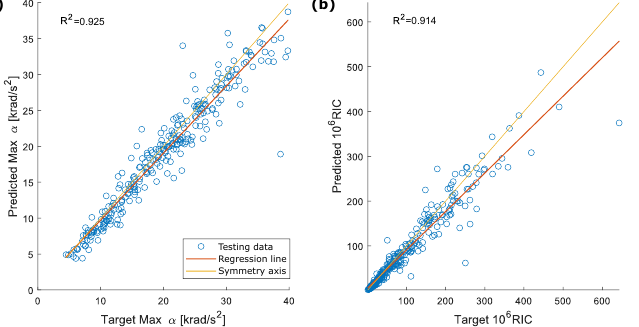
Figure 12. Correlation between ( a ) target and predicted peak for the resultant rotational acceleration and ( b ) target and predicted RIC for the reduced testing dataset (exclusion of impacts with peak rotational acceleration above 40 krad/s 2